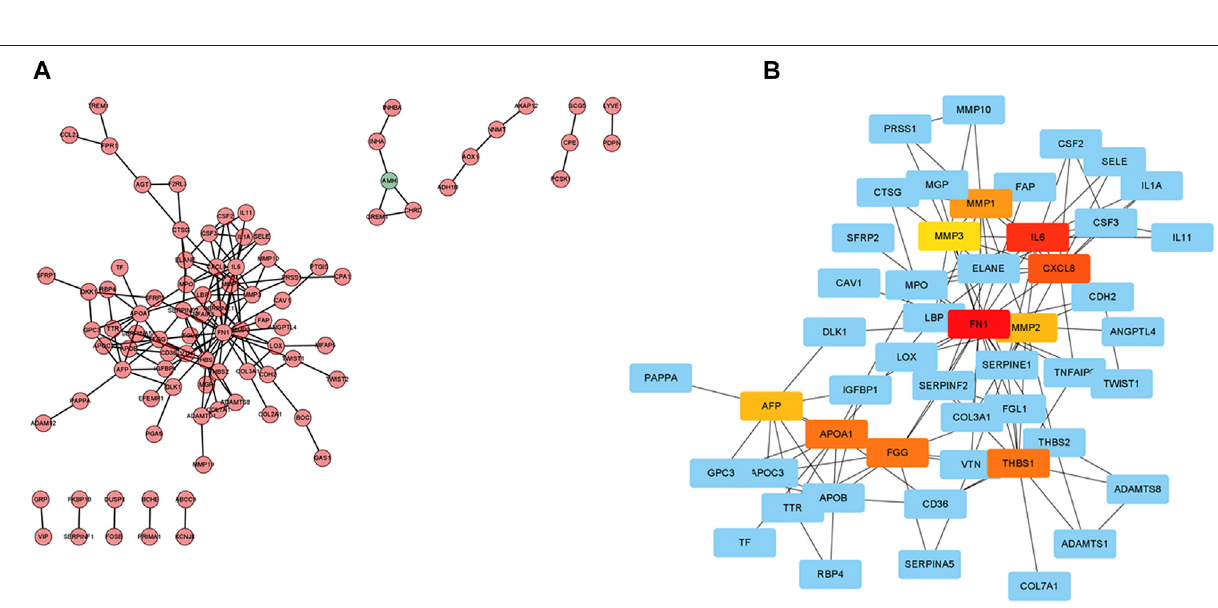
We identi fi ed 186 differential genes in two risk groups. GO and